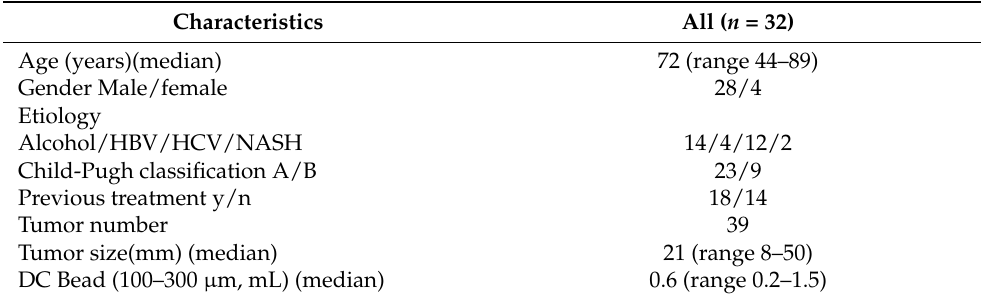
Table 1. Baseline patient and tumor characteristics. HBV: hepatitis B virus; HCV; hepatitis C virus; NASH: non-alcoholic steatohepatitis. Characteristics All ( n =